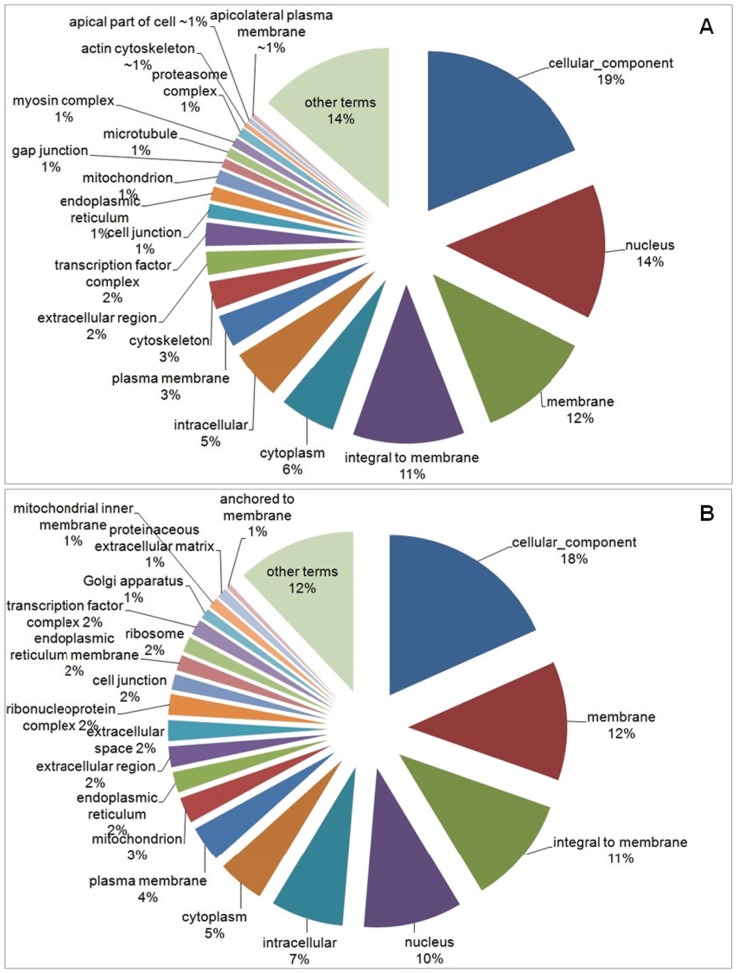
Pie-chart of Top20 GO terms for Cellular Component category.Representation of Top20 GO terms results from the down- (a) and up-regulated genes (b) for Cellular Component category, in the experimental group compared to control. The other terms, in addition to Top20, were represented together.